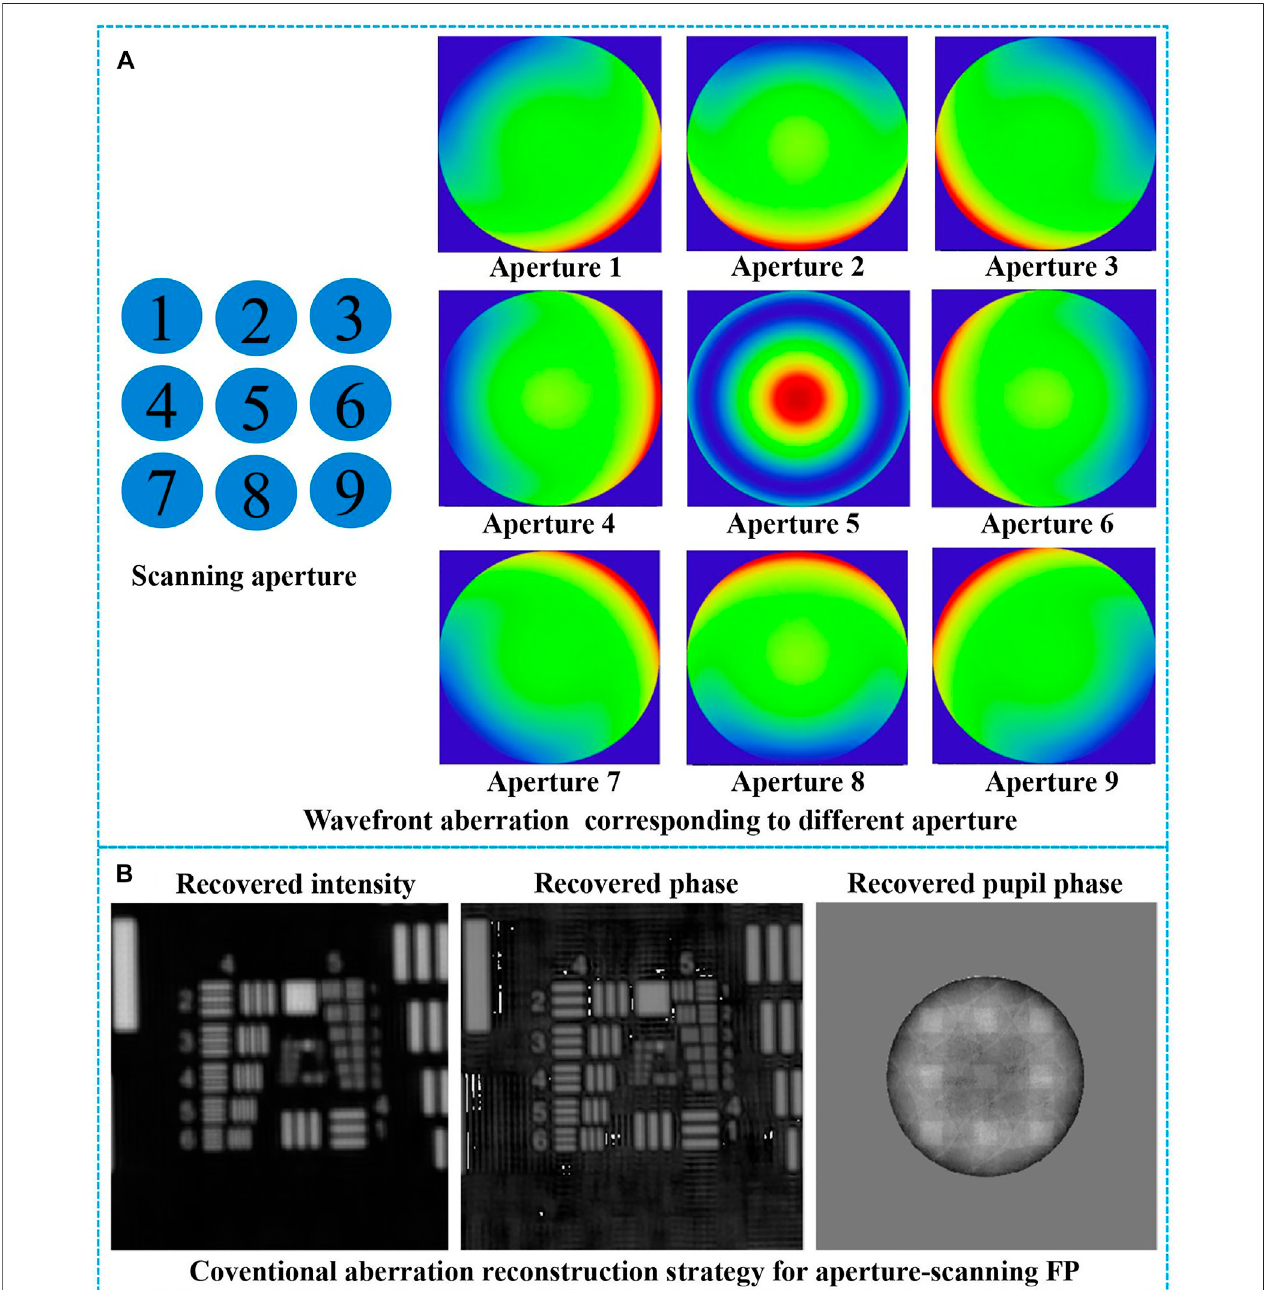
FIGURE1| (A) The pupilfunctions correspondingtodifferentaperturesin theprocess ofaperturescanning. (B) Therecoveredamplitude,phase, and pupilphase by the conventional aberration correction Fourier ptychography (FP) algorithm.